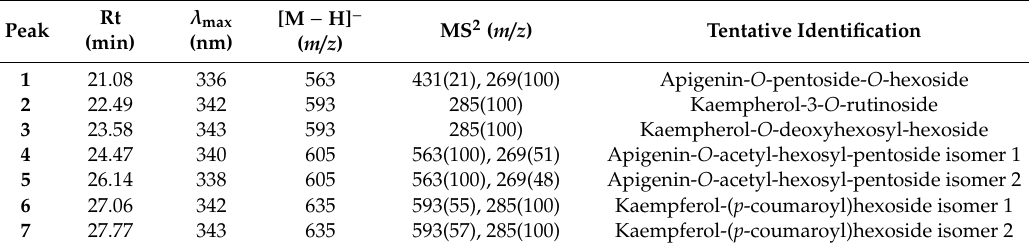
Table 1. Retention times (Rt), wavelengths of maximum absorption in the visible region ( λ max), mass spectral data and tentative identification of the phenolic compounds present in the hydroethanolic extracts of the tested parsley